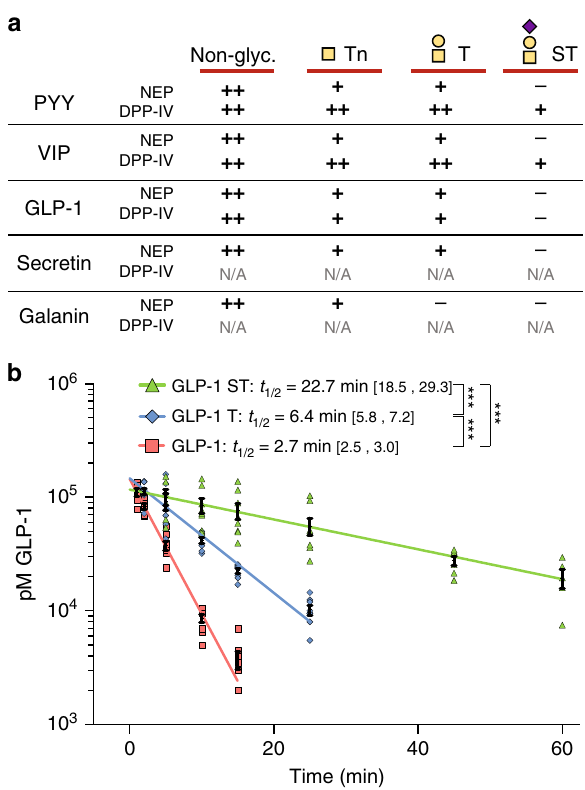
Fig. 6 Stability of glycosylated peptide hormones in vitro and in vivo. a Summary of in vitro degradation of peptide hormones using puri fi ed NEP or DPP-IV monitored by matrix assisted laser desorption/ionization-time of fl ight (MALDI-TOF) timecourse assay (See Supplementary Fig. 8 for spectra). Qualitative scoring ++ : fully susceptible to degradation, + : reduced susceptibility, − : not susceptible to degradation. b Plasma concentrations of GLP-1 or glycoforms over time after intravenous bolus injection (20 nmol per kg) in anesthetized rats ( n = 8 rats per group). GLP-1 was measured by an assay targeting the amidated C-terminus of the molecule measuring total GLP-1 (intact 7 – 36 amide and metabolites hereof). Half-lives ( T 1/2 ) are indicated with 95% con fi dence intervals. For each glycoform, timepoints represented by n > 4 measurements were included in the analysis ( n (GLP-1) = 35, n (GLP-1 T) = 38, n (GLP-1 ST) = 41 measurements in total). Multiple linear regression was performed in b . ns not signi fi cant; *** p < 0.001 (all indicated p -values < 0.0001). Source data for b is provided as a Source data fi